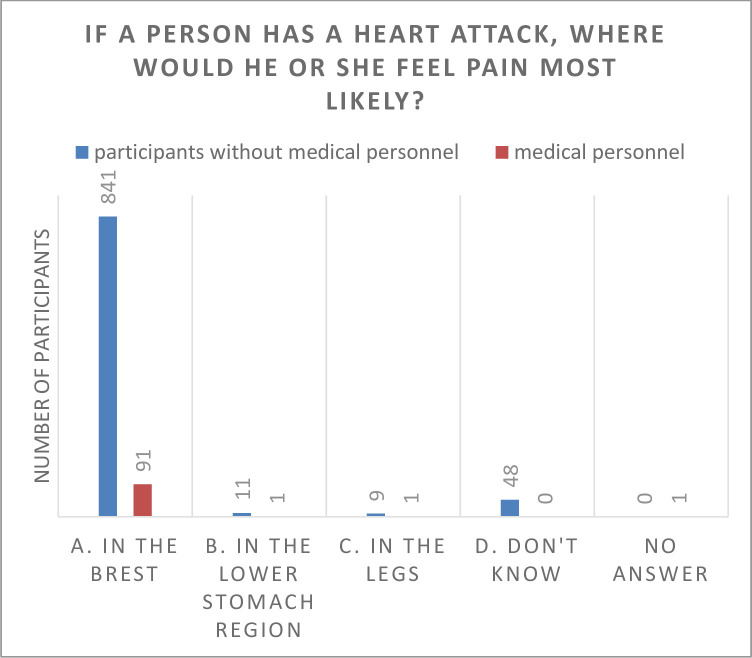
Answers given to question number 8 from medical personnel and other professions in comparison.